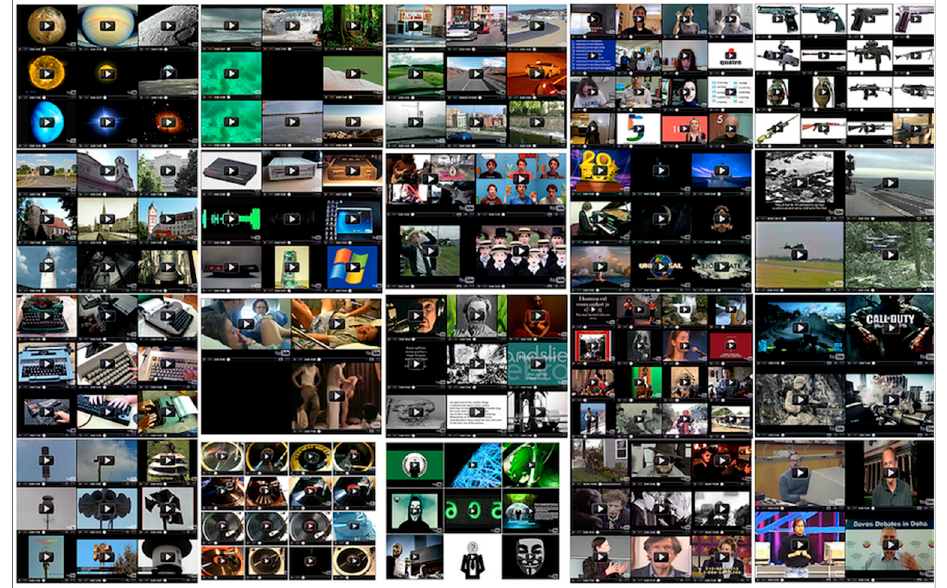
Figure 8. CuratingYouTube: An Acoustic Journey through YouTube , 2011. Screenshot of HTML soundbank, 2015. © CuratingYoutube, 2019.